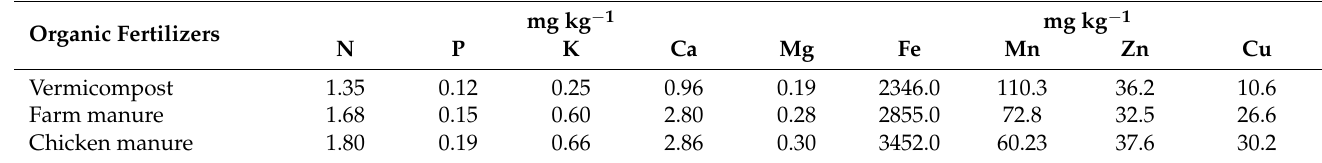
Table 2. Properties of the vermicompost and farm and chicken manure used in the